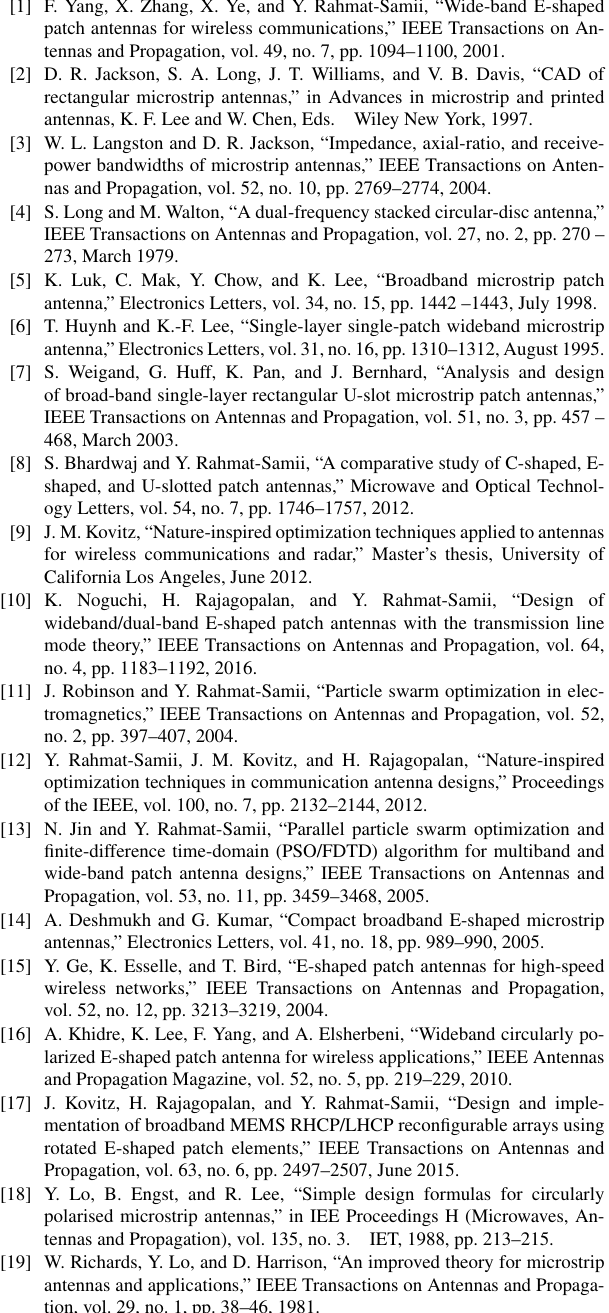
FIGURE 27. Investigations of laptop antennas using a back-to-back E-shaped patch antenna. Both human body interactions and antenna performance evaluation were studied. Adapted from